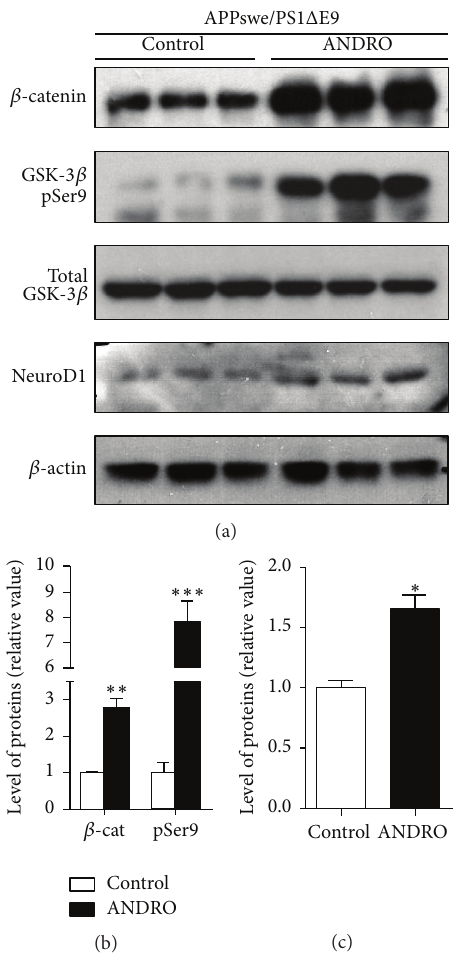
Figure 7: ANDRO increases NeuroD1 in the hippocampus of APPswe/PSEN1 Δ E9. Seven-month-old APPswe/PSEN1 Δ E9 mice were injected i.p. with 2 mgkg −1 ANDRO or vehicle as control 3 times a week per 4 weeks. (a) Immunoblots of 𝛽 -catenin, inactive form of GSK-3 𝛽 (phosphorylated in serine-9, pSer9), total GSK-3 𝛽 , NeuroD1, and 𝛽 -actin in total protein extracts obtained from the hippocampus of control and ANDRO-treated APPswe/PSEN1 Δ E9 mice. (b) Densitometric analysis of 𝛽 -catenin and GSK-3 𝛽 pSer9 normalized to 𝛽 -tubulin and total GSK-3 𝛽 , respectively. (c) Densitometric analysis of NeuroD1 normalized to 𝛽 -tubulin. Bars represent mean ± S.E. ( 𝑛 = 3 mice). ∗ 𝑃 < 0.05 , ∗∗ 𝑃 < 0.01 , and ∗∗∗ 𝑃 < 0.001 , Student’s 𝑡